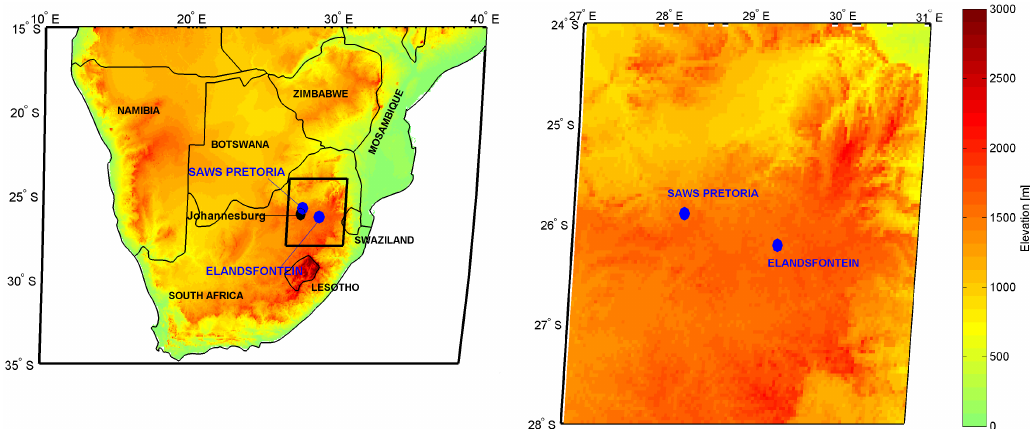
Fig. 1. Location of measurement site and the orographic information of the surroundings. The Elandsfontein lidar site was located 150km east from Johannesburg. The map shows the location of the Pretoria sounding station 120km from the lidar